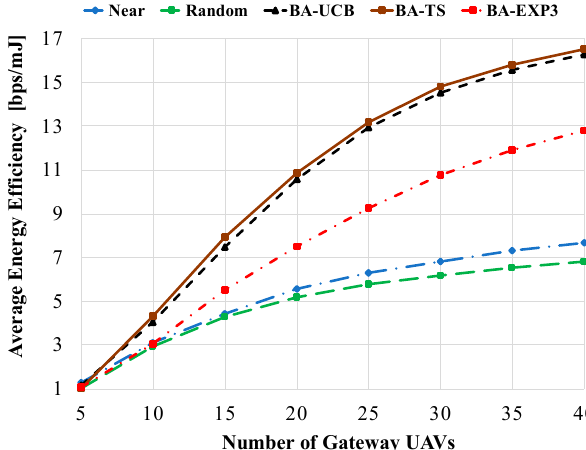
Figure 8. Average energy efficiency against the number of gateway UAVs using access UAVs of 20 and a beam-width of 60°.